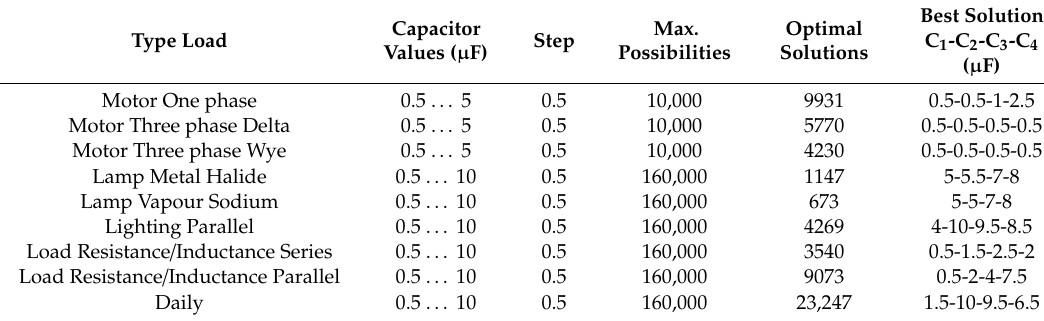
Table 6. Comparison of optimization results of capacity for CB.